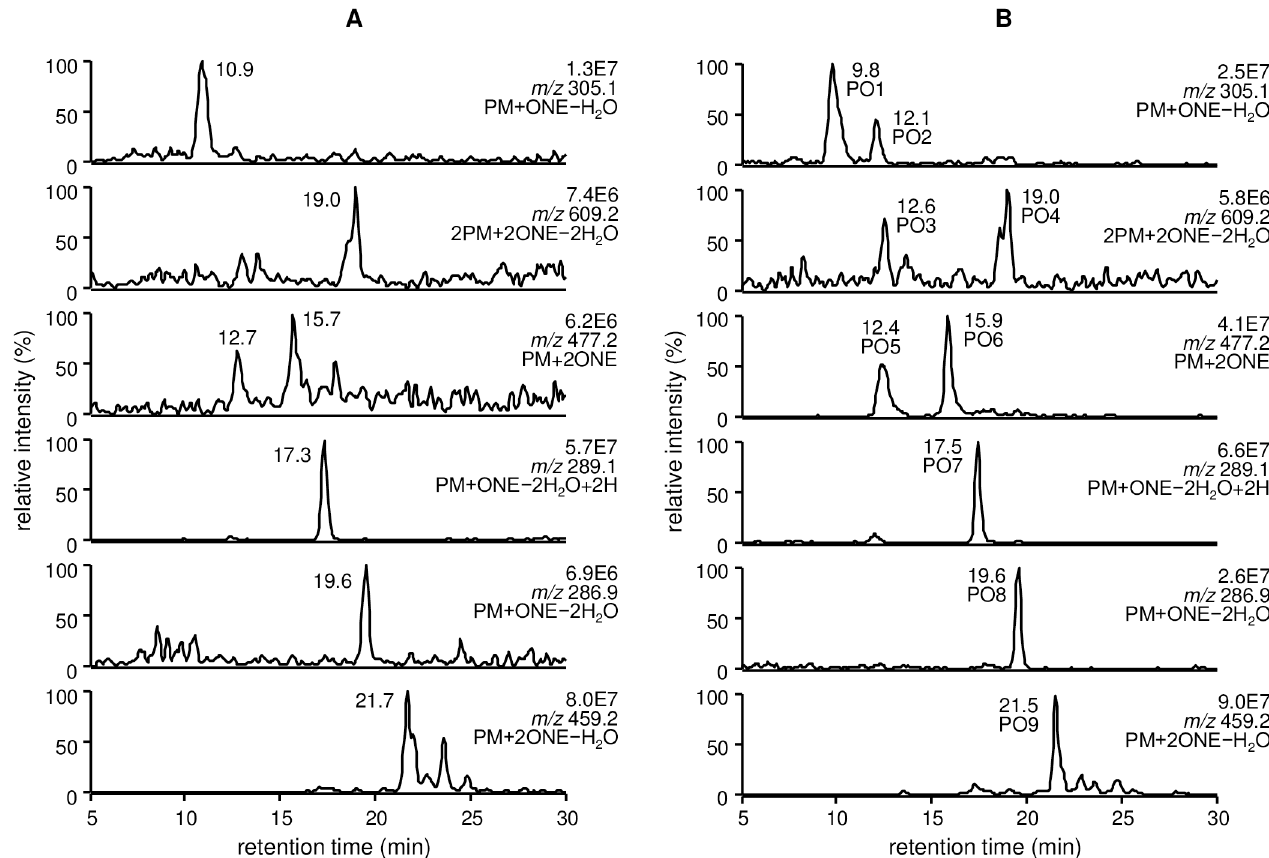
Fig 1. LC/ESI-MS analysis of the reaction between PM and ONE at 37 ˚C for (A) 24 h and (B) 5 days.